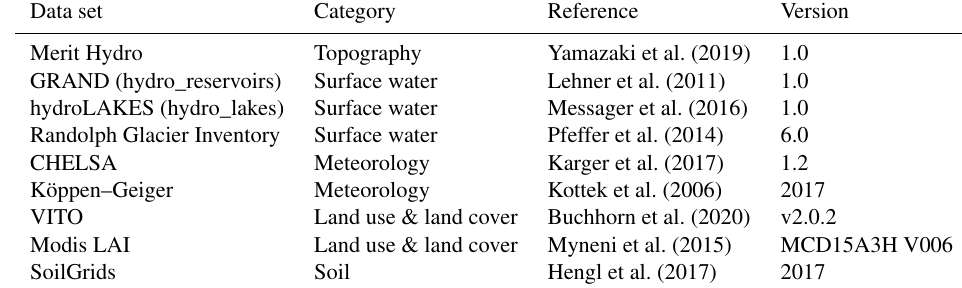
Table 1. Overview of data sources for parameter estimation with categories, references, and version.